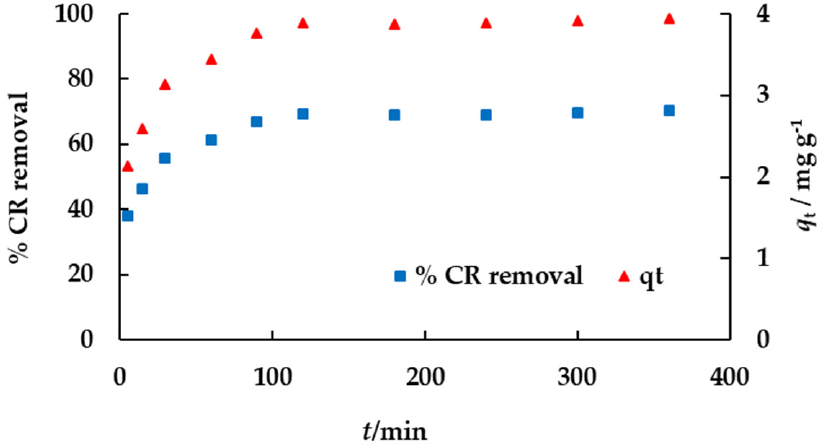
Figure 6. The effect of contact time on the biosorption of CR to EP ( γ CR = 50 mg dm − 3 , γ biosorbent = 8 mg dm -3 , pH = 7, T = 298.15 K, v = 150